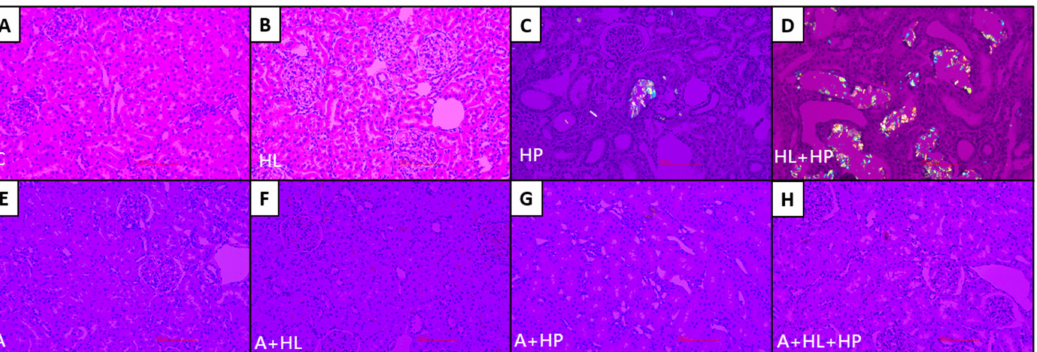
Figure 3. Representative micrographs of renal cortex and medulla photographed using a polarized microscope. ( A ) Control. ( B ) Hyperlipidemia (HL). ( C ) Rats treated with 5% hydroxyproline (HP). ( D ) HL rats treated with 5% HP. ( E ) Controls treated with atorvastatin. ( F ) HL rats treated with atorvastatin. ( G ) Rats treated with 5% HP and atorvastatin. ( H ) HL rats treated with 5% HP and atorvastatin. All images above were demonstrated with original magnification 200 ×